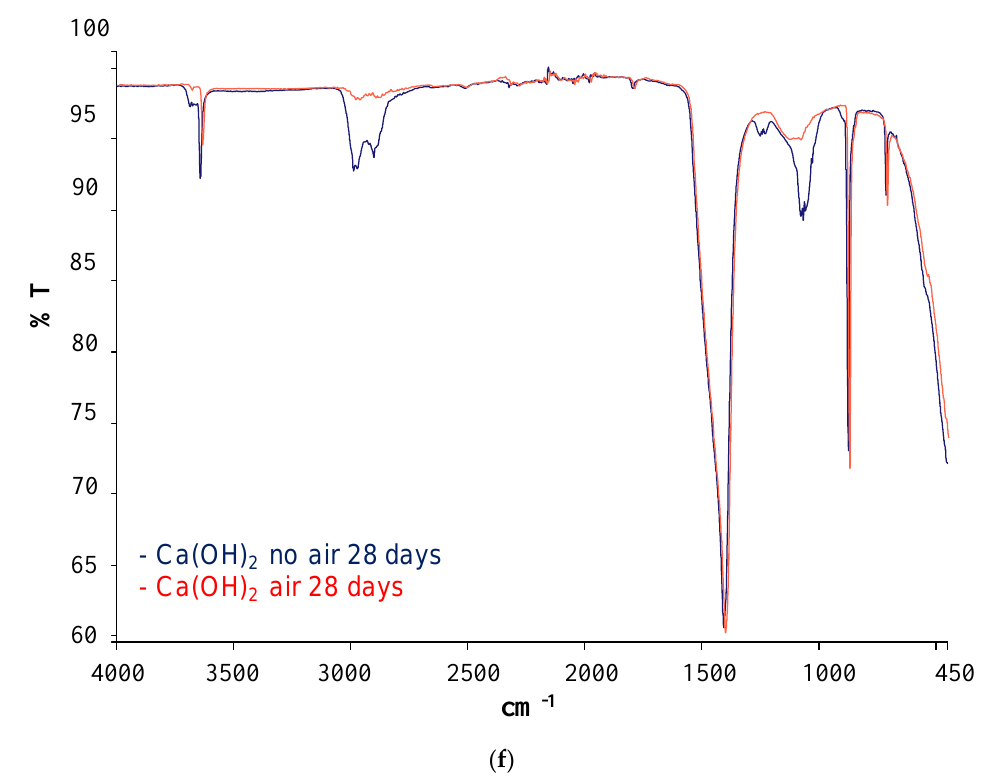
Figure 8. FT-IR for the pozzolanic test. ( a ) bauxite, ( b ) chamotte, ( c ) iron silicate, ( d ) silica fume, ( e ) steel slag, ( f ) Ca(OH) 2.